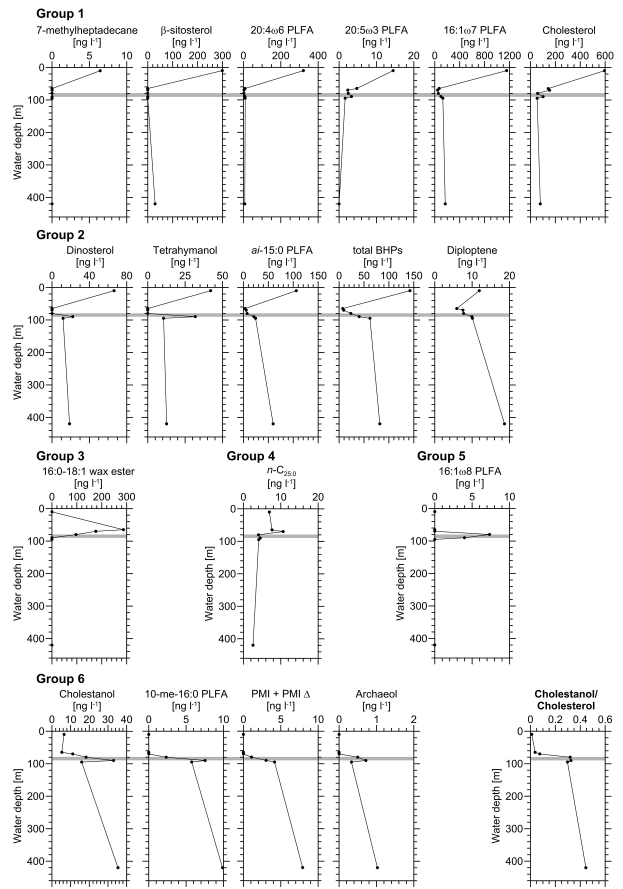
Figure 4. Vertical distribution of biomarkers in the Landsort Deep water column. The suboxic zone is shaded grey.